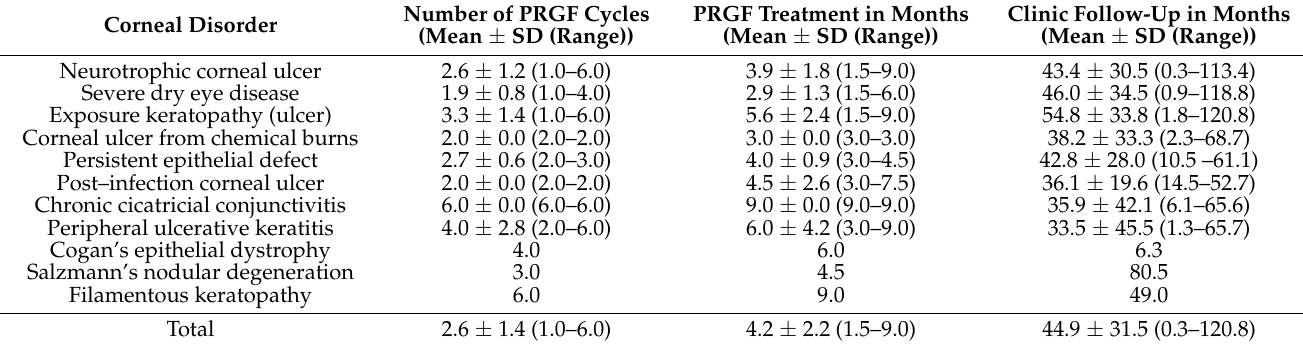
PRGF: Plasma Rich in Growth Factors, SD: Standard